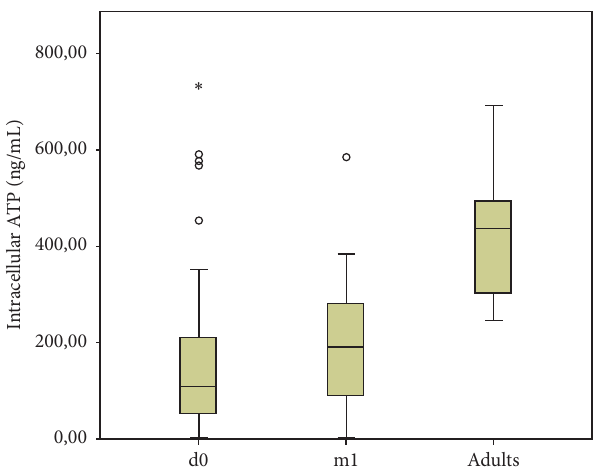
Figure 1: CD4+ T-cell activity (median iATP values) in preterm infants and in adult controls (d0: evaluation at birth; m1: evaluation at 30 days of life). Outliers are marked as ∘ (“out values”: 1,5–3 × interquartile range, IQR) and ∗ (“extreme values”: > 3 × IQR).